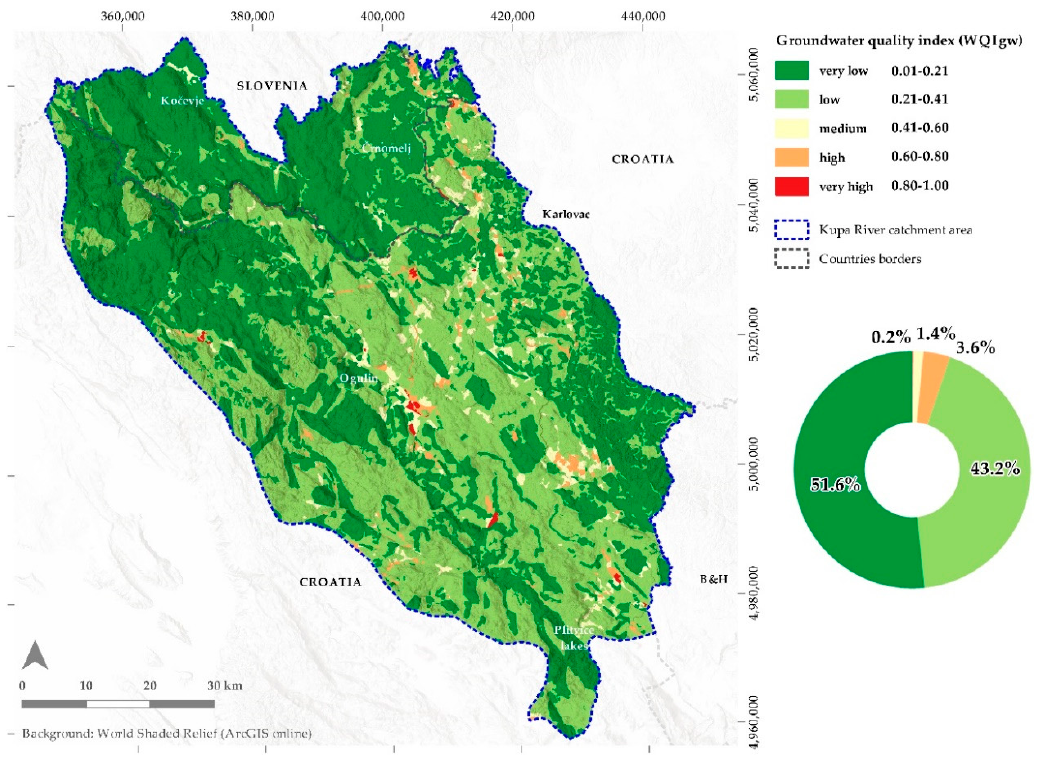
Figure 6. Groundwater quality index ( WQIgw ) for the Kupa River catchment, with the percentage of the respective class.